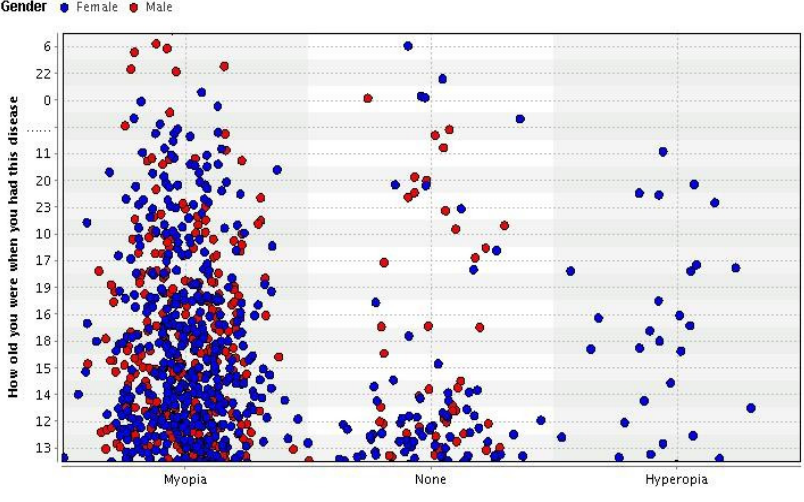
Figure 4. Scatter chart of eye diseases vs. age.